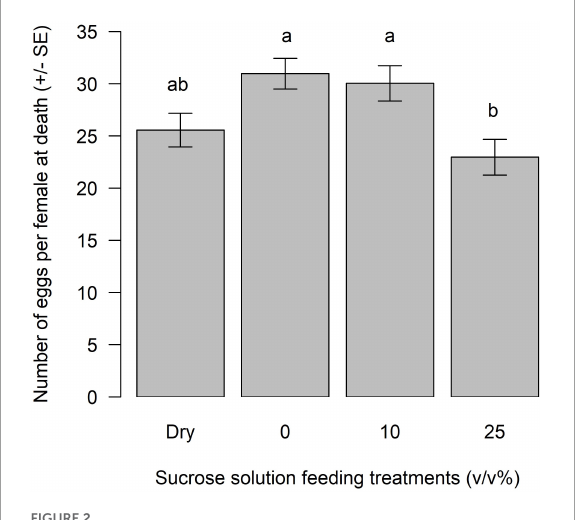
FIGURE1 Mean longevity (d) of unmated Apanteles polychrosidis fed various sucrose feeding treatments. Each wasp ( n = 41–55 per treatment) was provided with a feeding treatment of either 10 or 25% (v/v) sucrose in deionized water, a deionized water control (0), or a dry feeder control dry. Bars marked with different letters are significantly different ( p < 0.05) [compact letter display (cld) of multiple pairwise comparisons].